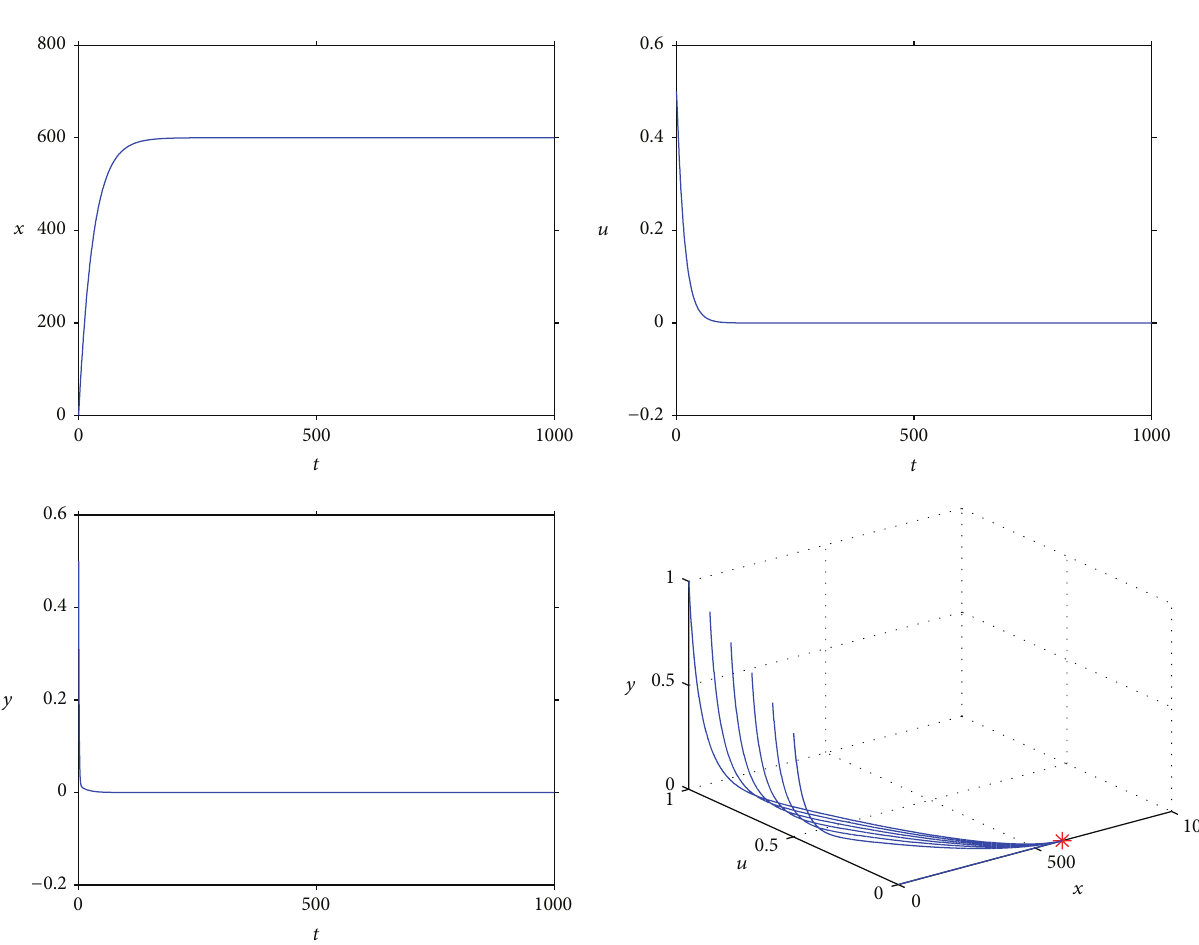
Figure 2: Global stability of the infection-free equilibrium 𝑃 0 when 𝑅 0 < 1